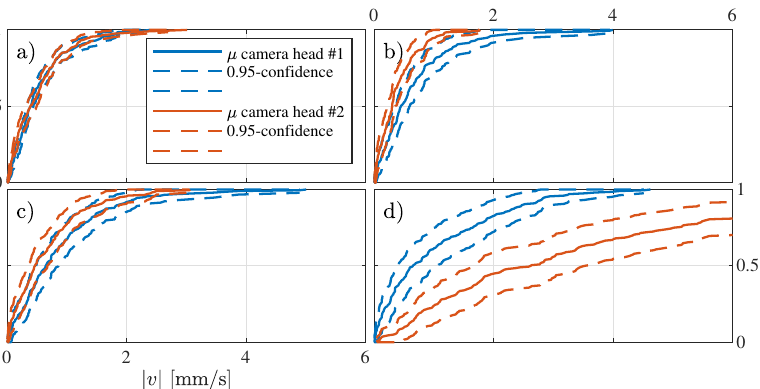
Figure 8. Comparison of the estimated speed cumulative distribution for each camera head for ( a – d ) the combinations of priors T-T, T-U, U-T, and U-U,